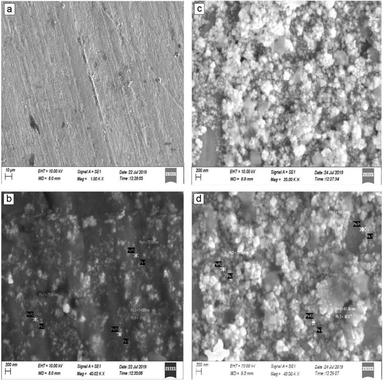
a) Bare Ti; b)ZnONPs/CS/Ti;c)ZnO,AgNPs/CS/Ti; d)ZnO,AuNPs/CS/Ti.Energy Dispersive X-ray Analysis (EDX)